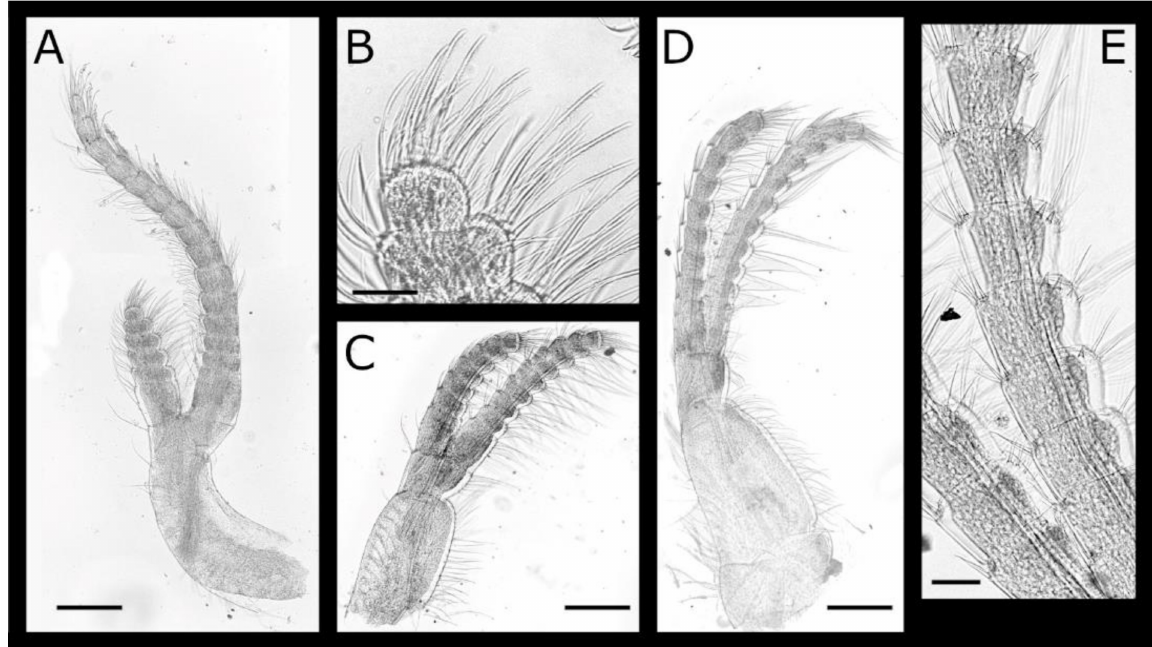
Figure 7. Acasta fenestrata Darwin, 1854 cirri I–III (all WAM C58749). ( A ) left cirrus I; ( B ) serrulate setae on left cirrus I distal segments of posterior ramus; ( C ) left cirrus II; ( D ), left cirrus III; ( E ) erect spines on left cirrus III anterior ramus. Scale bars: A, B–C = 200 µ m; D, E = 50 µ